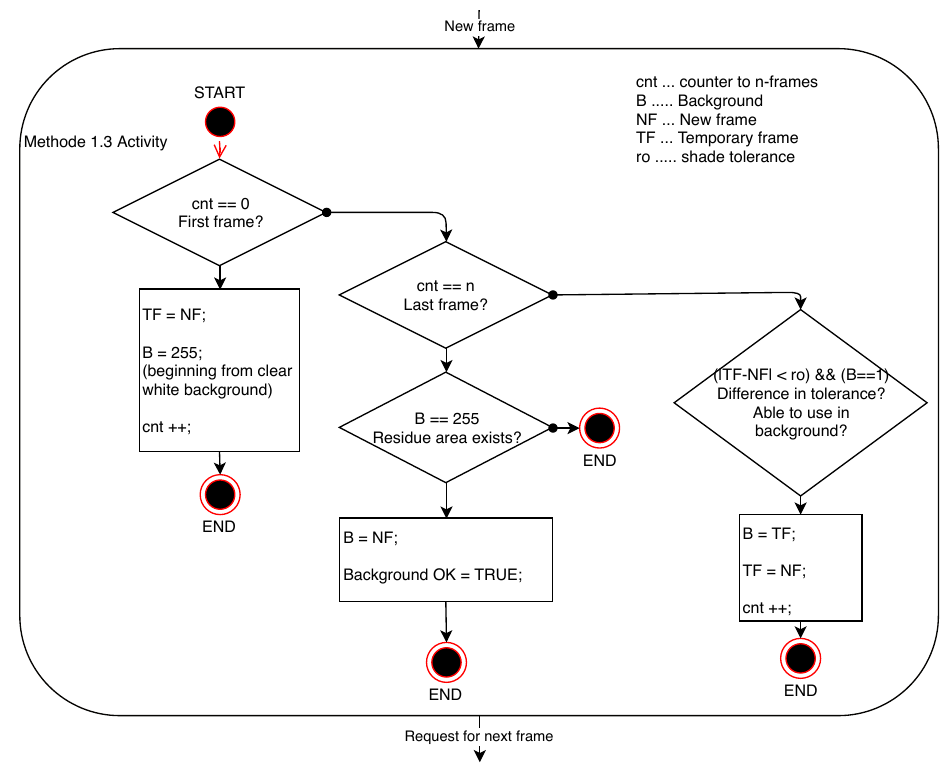
Figure 7. Diagram of Method 1.3 activity.